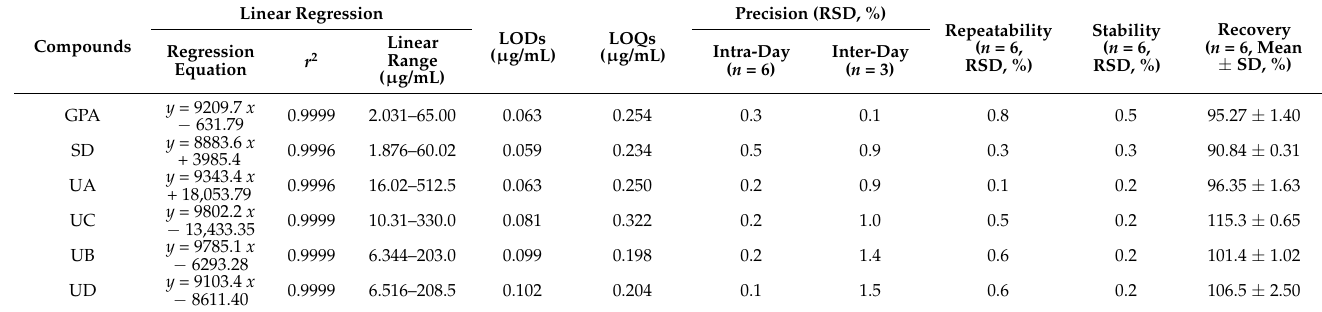
Table 1. Summary results of linear regression, LODs, LOQs, precision, repeatability, stability, and recovery for six tested compounds in seed meal of E. ulmoides